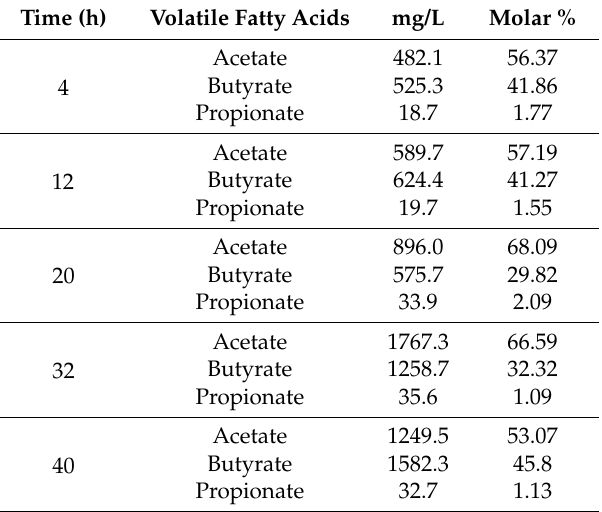
Table 3. Production of volatile fatty acids during biohydrogen